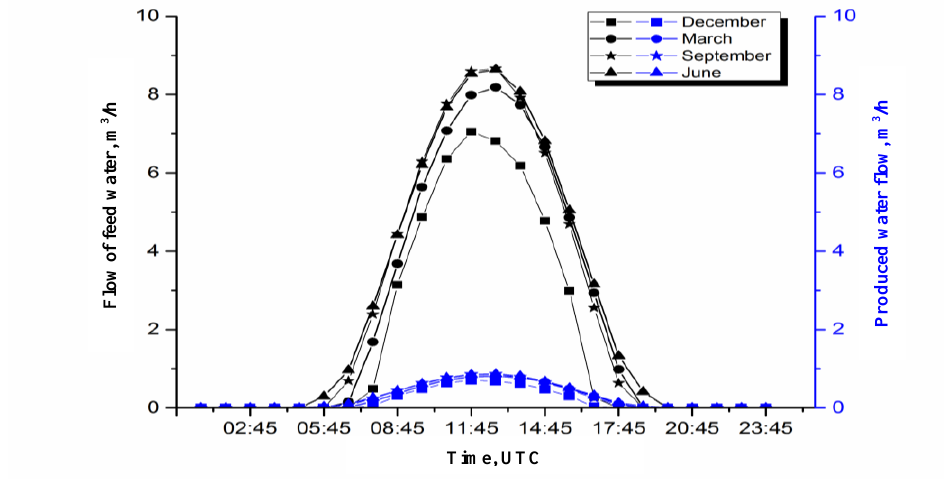
Fig. 6. Flow of feed water and produced water flow for a concentration C a = 6 g/l and a conversion rate y = 10 % in